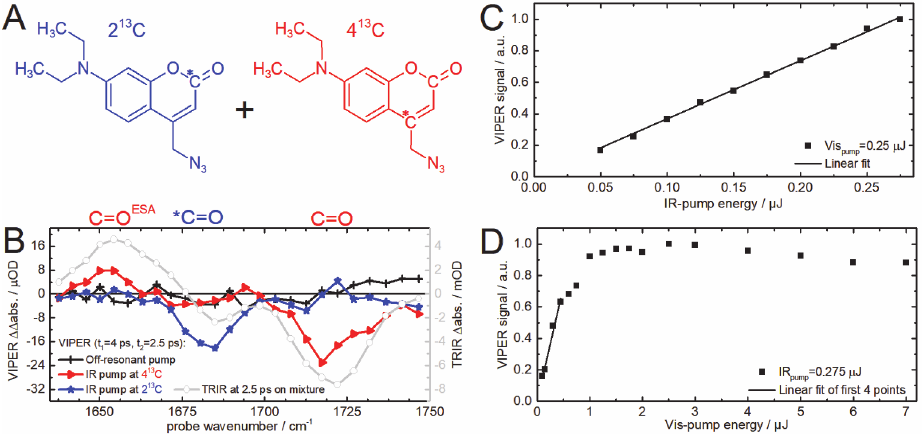
Fig. 1. A Chemical structures of the two DEACM isotopomers, with 13 C at position 2 (2 13 C; blue molecule) and at position 4 (4 13 C; red). The isotopomer is marked with a star. B Comparison of the VIPER and TRIR data on a 40/60 mixture of 2 13 C/4 13 C. Above the graph the mode assignments are given, with ESA denoting the electronically excited state. The TRIR data are obtained with resonant Vis excitation at 400 nm. For the VIPER experiment, the delays represent the timings of the IR pump (t 1 ) and the off-resonant VIS pump (t 2 ; centered at 437 nm) pulses with respect to the IR probe pulse. C-D Optimization study of coumarin 6, depicted together with linear fits to the data (black lines). C The normalized VIPER signal scales linearly with the IR pump pulse energy. D The normalized VIPER signal grows only linearly for low VIS pump